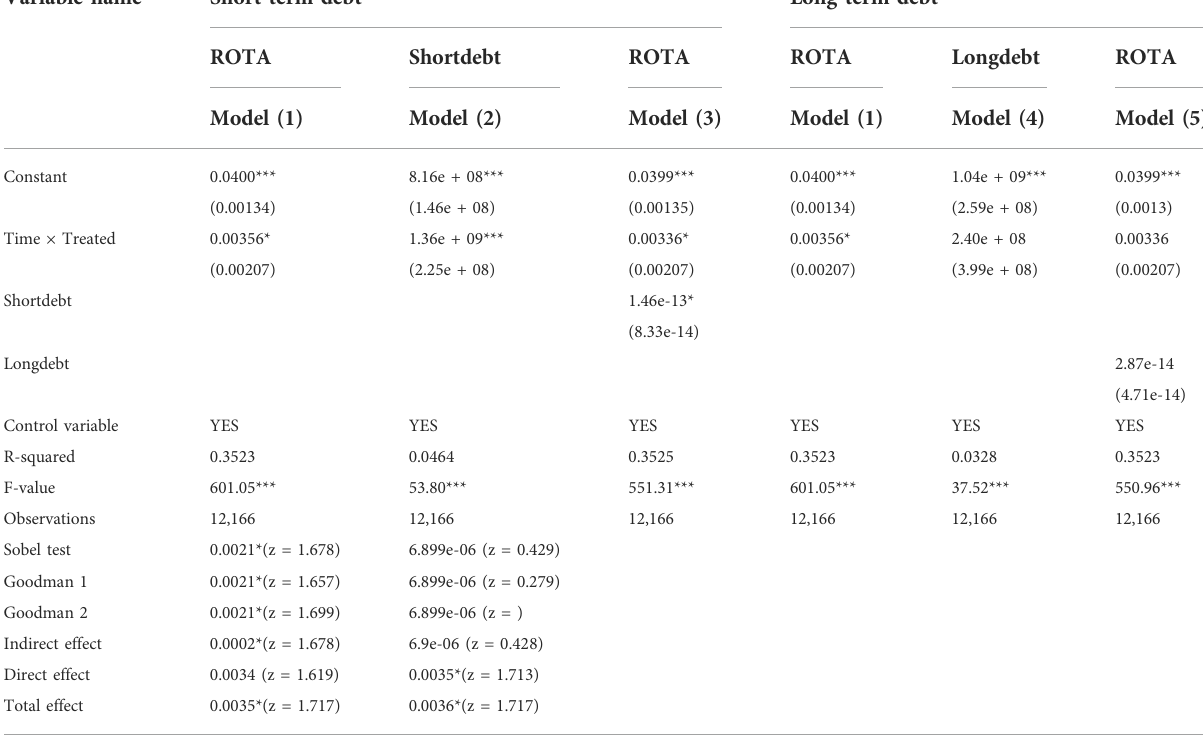
TABLE 7 Mediation effect test based on short-term debt and long-term